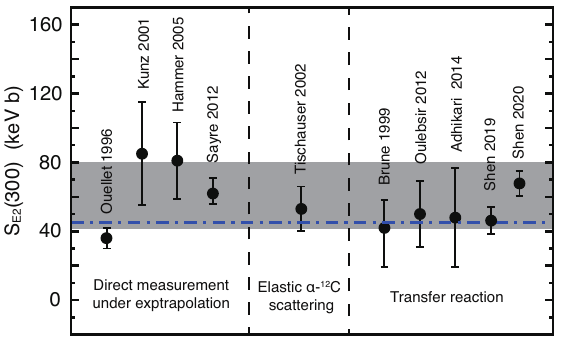
Figure 2. The S E 2 (300) comparison [11, 15, 17, 23–29]. The grey shadow represents the compilation value of NACRE II (2013) [30]. The blue dot-dashed line is the value in deBoer et al. (2017)